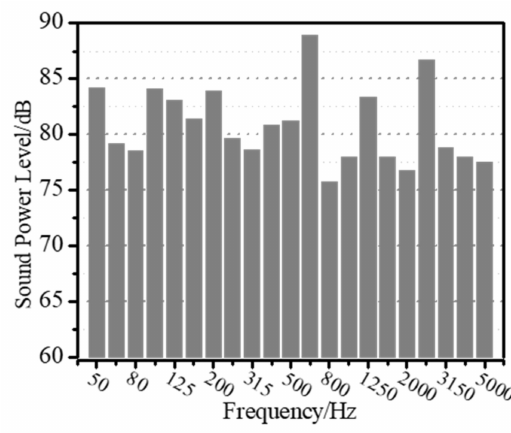
Figure 3. Numerical simulation input sound